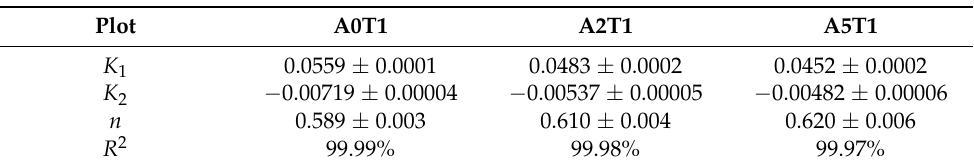
Table 3. Values of the parameters of the Peppas and Sahlin Equation for each sample (inset Figure 3, first eight hours).